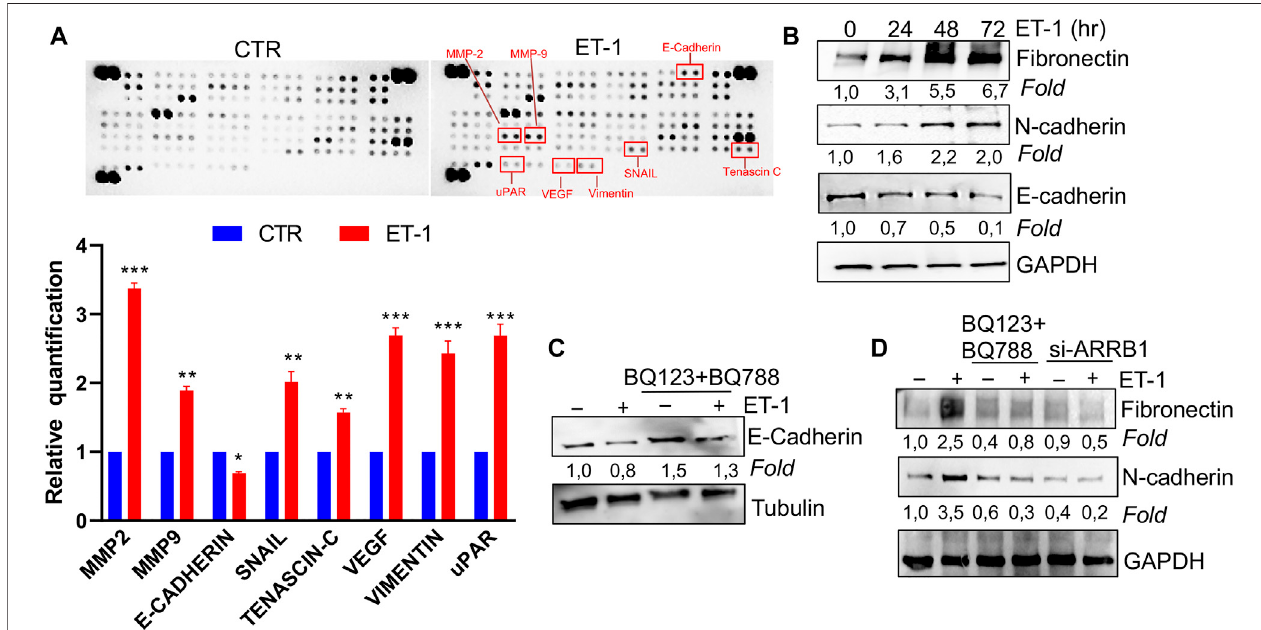
FIGURE 3 | ET-1 regulates MMT marker expression through ET A R and ET B R/ β -arr1 axis. (A) Detection of multiple analytes in CM from untreated or ET-1-treated cells (72 h) by using proteome pro fi ler array. The graph summarizes the relative signal intensity of indicated molecules and is shown as fold-over CTR. Histograms, the mean ± SD, n (cid:2) 2. One-way ANOVA. (B) Representative WB analysis of indicated proteins in MCs stimulated with ET-1 at indicated times. (C) Representative WB analysis of E-Cadherin in MCs stimulated with ET-1 and/or BQ123+BQ788 at 48 h (D) MCs transfected with si-ARRB1and stimulated by ET-1 and/or BQ123+BQ788 for 48 h. Proteins were normalized in comparison with the GAPDH or Tubulin, used as the loading control, and indicated as fold-over CTR.